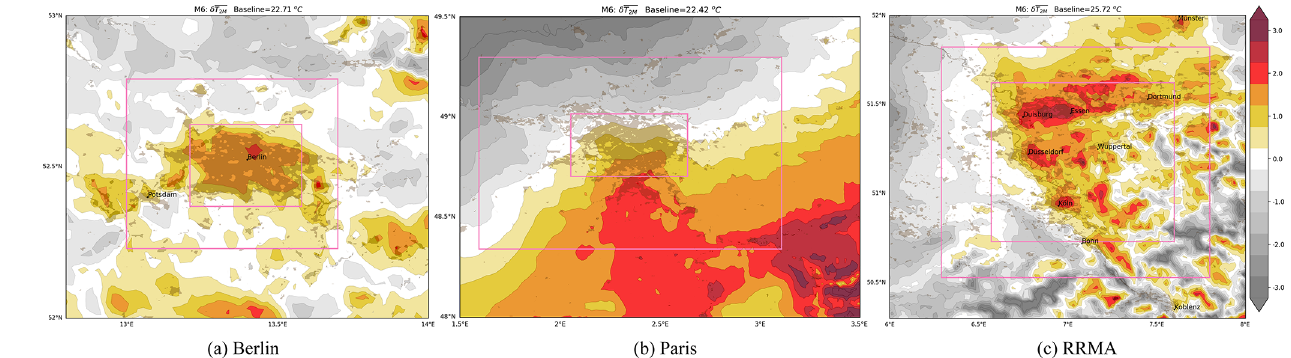
Figure A3. UHI calculated with M6 on the original grid (no interpolation) for Berlin, Paris and the Rhine-Ruhr Metropolitan Area (a–c) , with the height gradient correction. The baseline used is the same as M4.